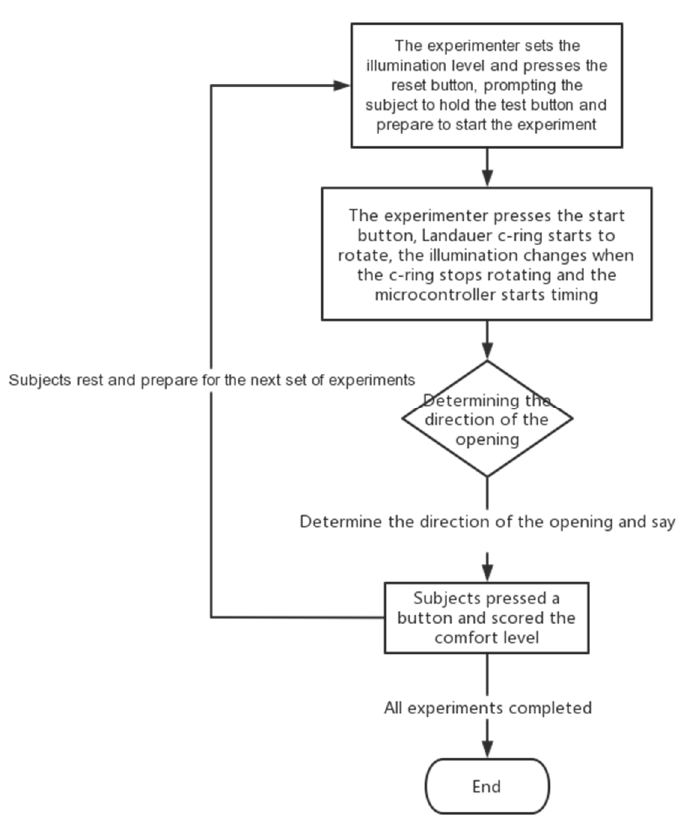
Figure 7. Experimental flow diagram.